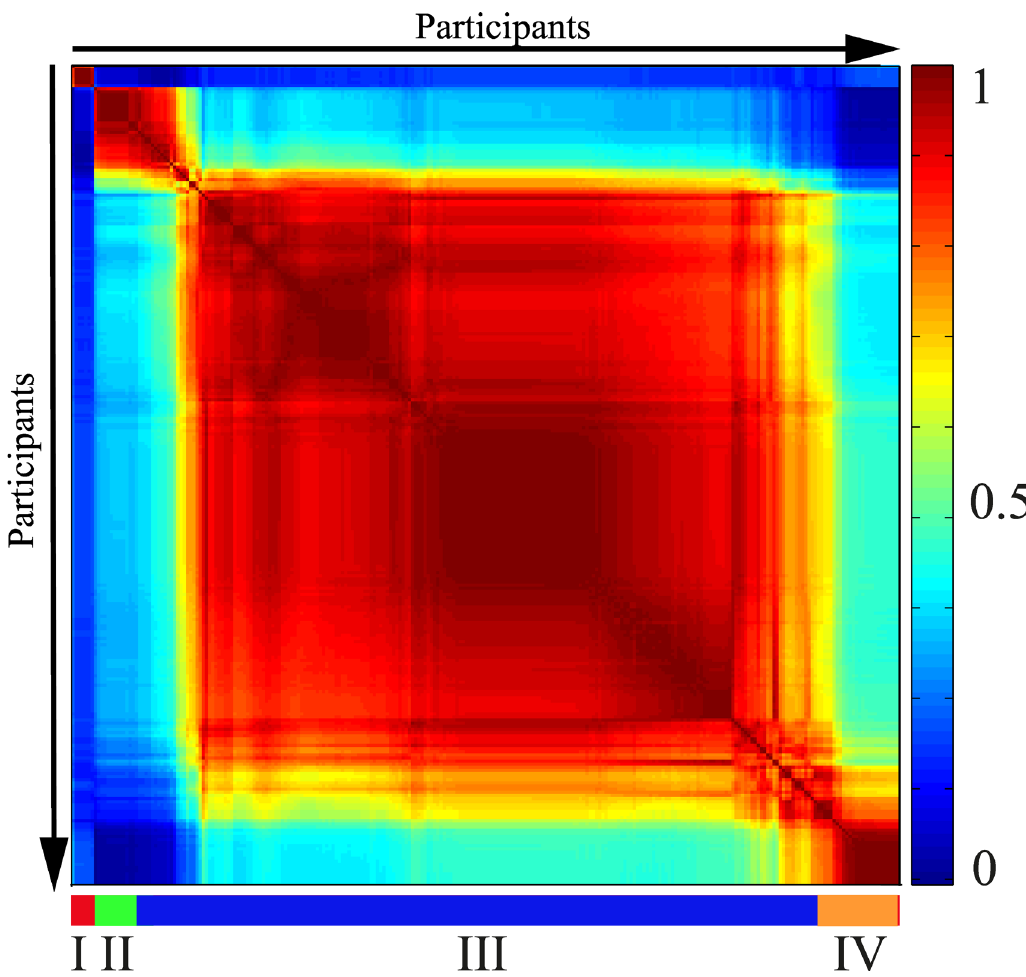
Fig 1. Spectral Clustering co-occurrence plot. Participants are ordered along both X- and Y-axis according to the co-occurrence score (i.e. the more similar the peptide profiles of any two participants, the higher their tendency to cluster together and the closer they are placed on the axis). Co-occurrence score values range from 0 (for participants who never cluster together) to 1.0 (for participants who always cluster together). The horizontal bar delimits the four